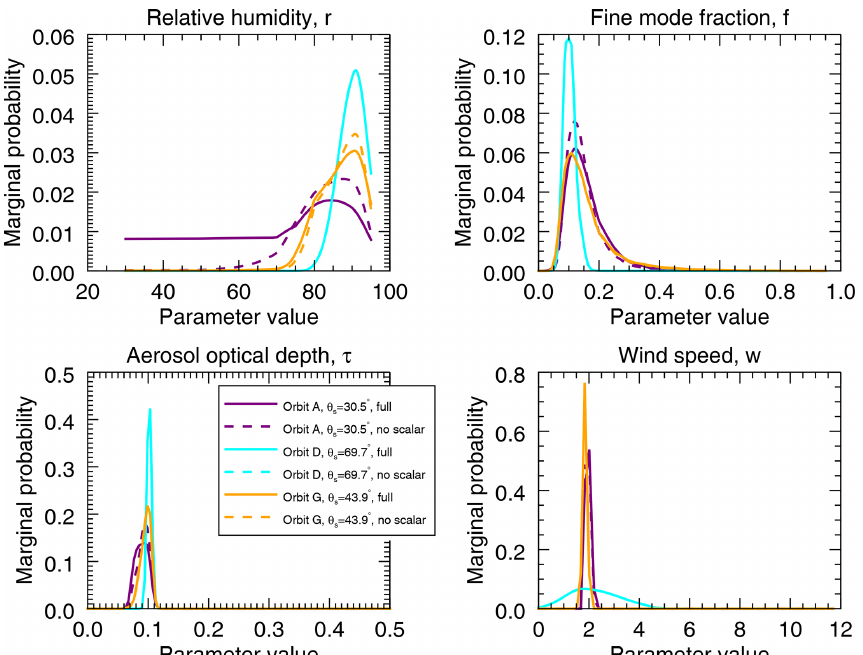
Figure 11. Marginal PDFs for the parameter sets in Figs. 3, 5, and 4 ( r = 90%, f = 0 . 10, τ = 0 . 10, and w = 1 . 87ms − 1 ). Solid lines indicate assessment with the full uncertainty model, including model error estimates for the use of a scalar rather than vector sun glint parameterization. Dashed lines are the marginal PDFs for the case where that term has been omitted. Lack of dashed lines for a case indicates that there is no difference in the marginal PDF compared to that using the full model